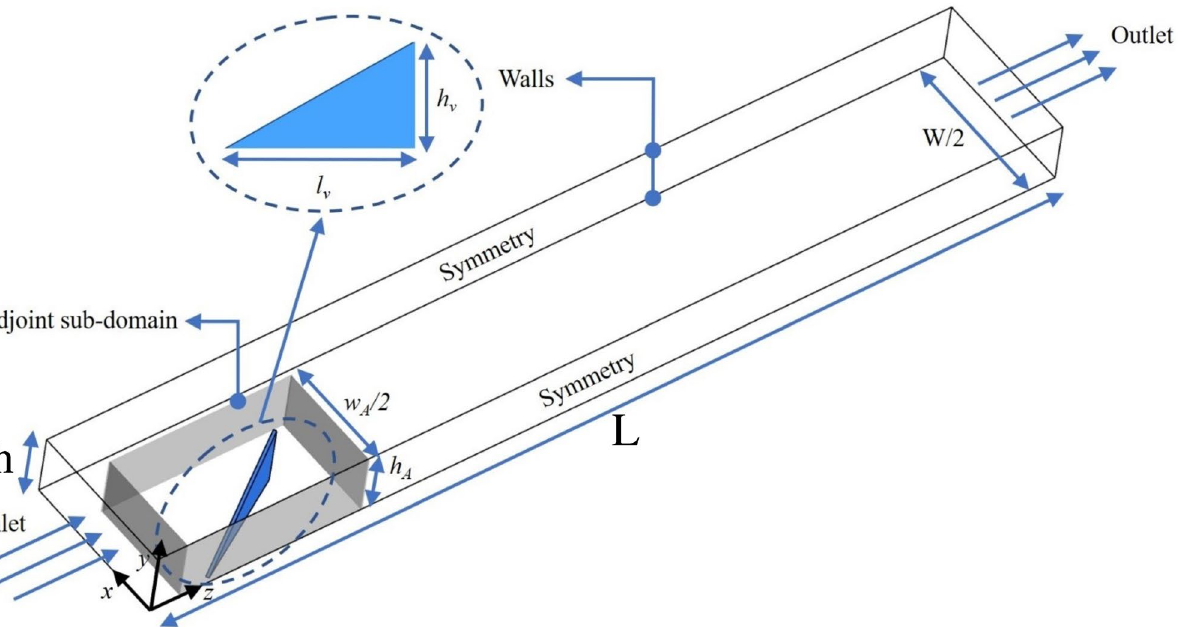
Figure 9. Computational domain showing the boundaries of the channel. Velocity inlet and pressure outlet are imposed respectively at the inlet and outlet. Symmetry is imposed at the external boundaries. Rigid walls with no-slip velocity boundary conditions are imposed on the RVGs surface and on top and on bottom of the channel. Constant uniform temperature T w is imposed on top and on bottom walls while an adiabatic boundary condition is applied at the RVG